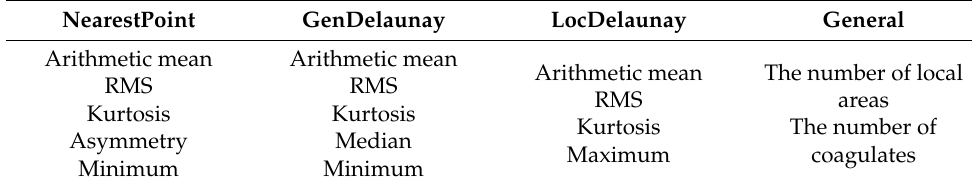
Table 4. Uncorrelated